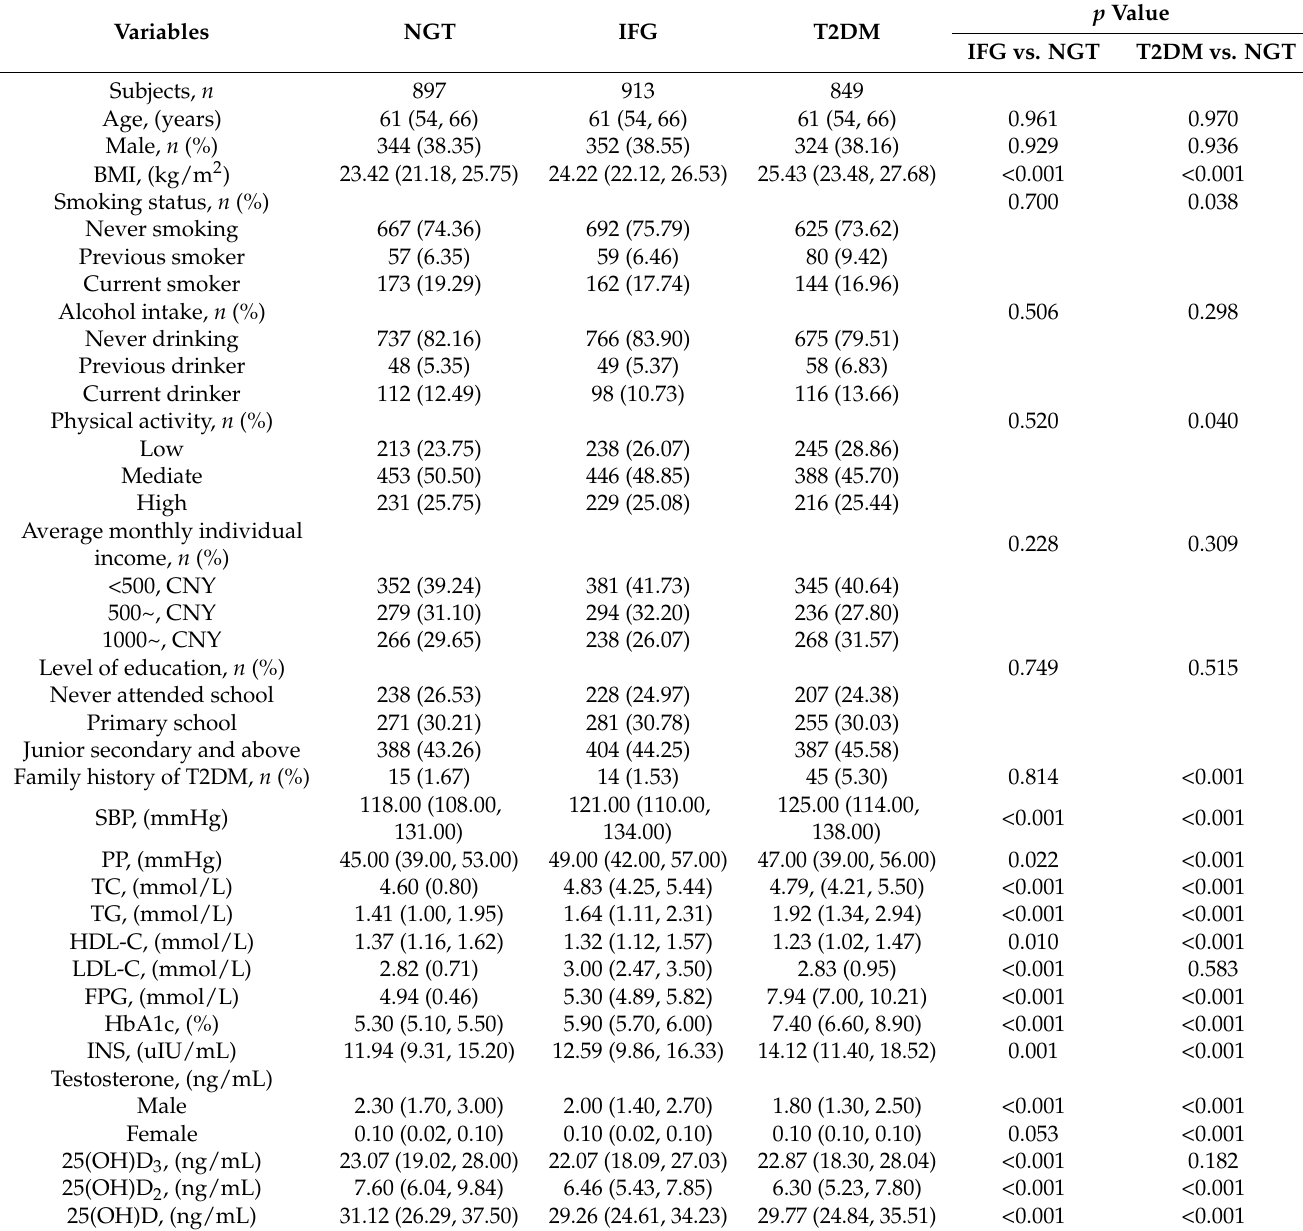
Table 1. Characteristics of the participants according to diabetes